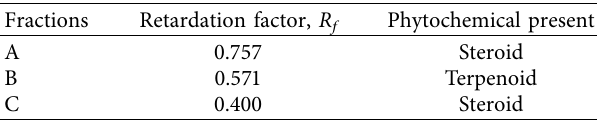
Table 10: Chromatographic fractions separated, their respective R values and confrmed phytochemical screening